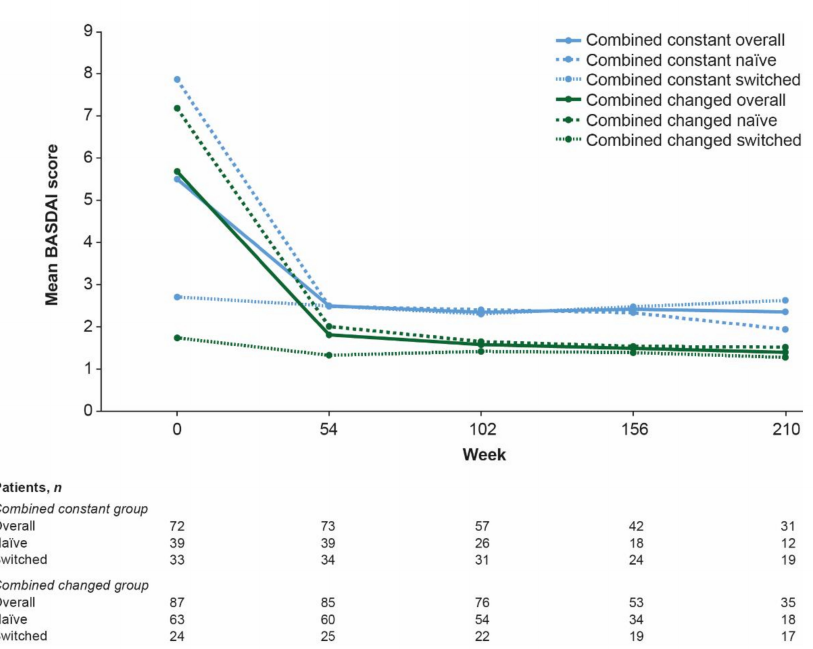
Figure 4. Mean BASDAI scores 1 by treatment group for combined constant and combined changed groups. 1 BASDAI results are not presented for week 264 as there was only one evaluable patient. BASDAI, Bath Ankylosing Spondylitis Disease Activity